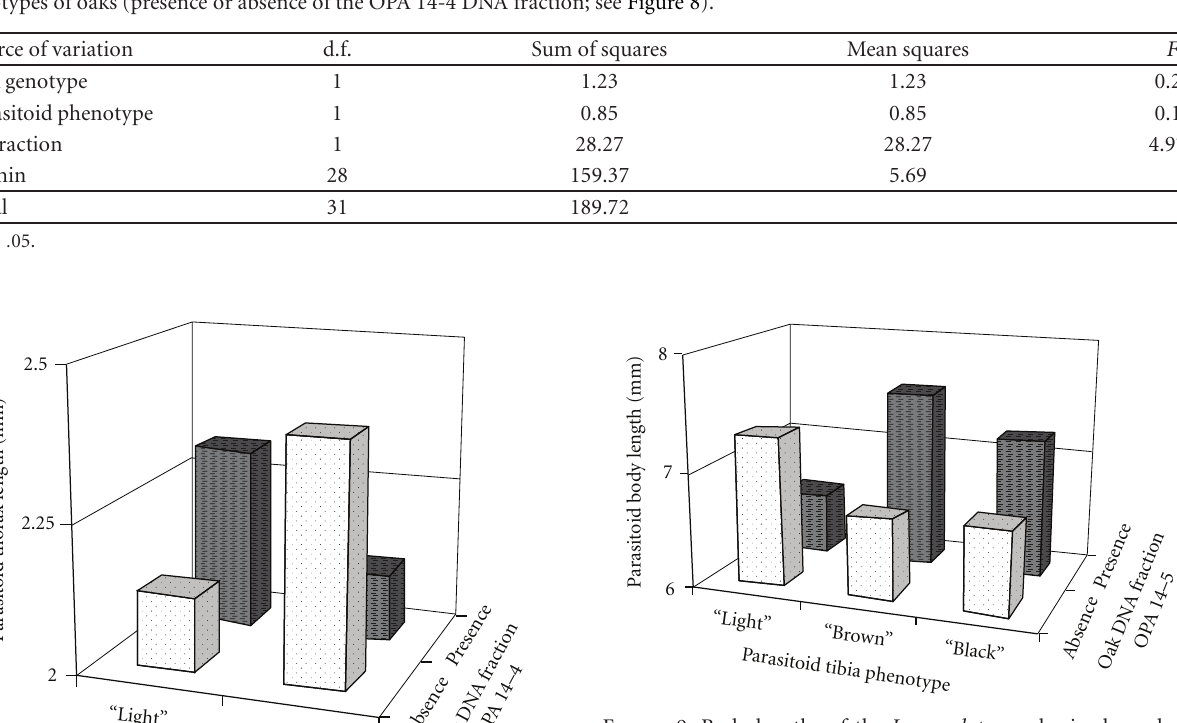
Figure 9: Body lengths of the I. maculator males in dependence on their phenotypes and genotypes of oaks (presence or absence of the OPA 14-5 DNA fraction) on which their host insect pupae were developed (results of two-way ANOVA in Table